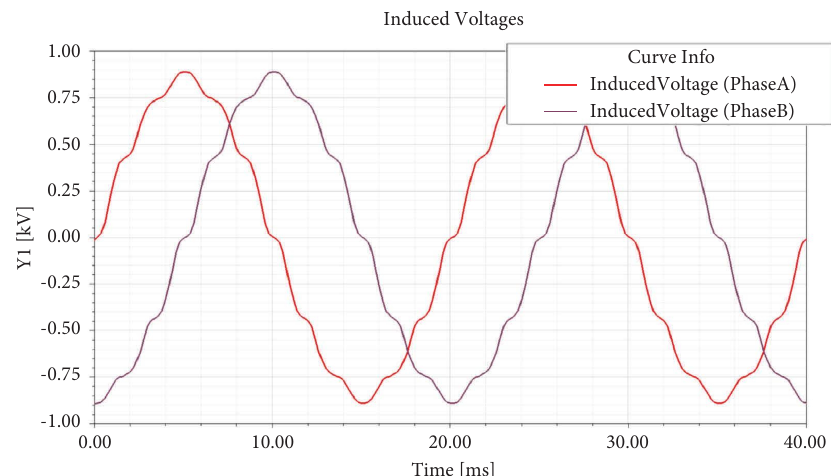
Figure 34: Back EMF curve of fat-bottom ladder slot motor.